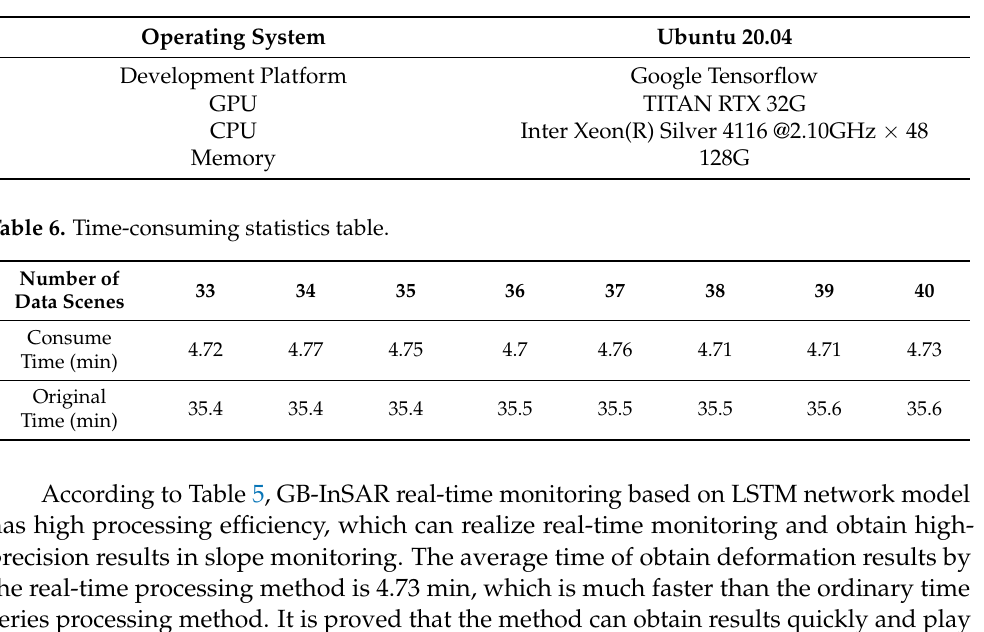
Table 5. Experimental environment configuration.